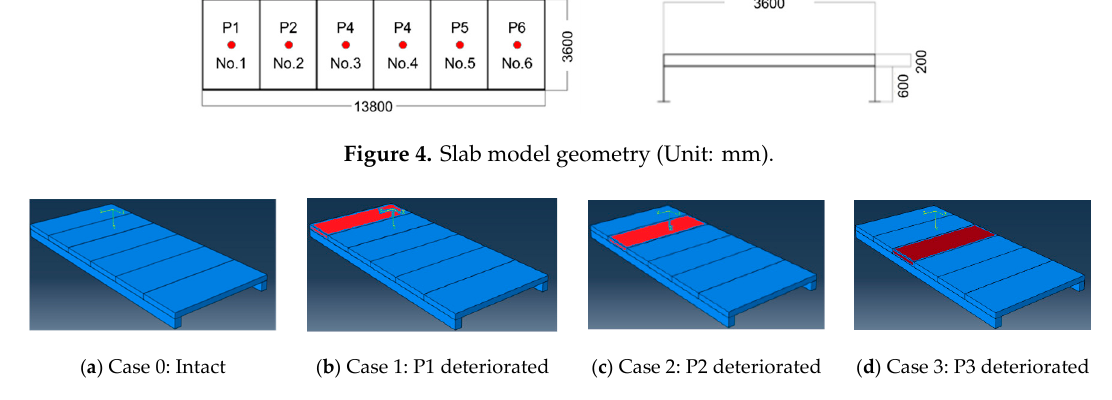
Figure 5. FEM (Finite Element Method) models for a slab with simulated damage.